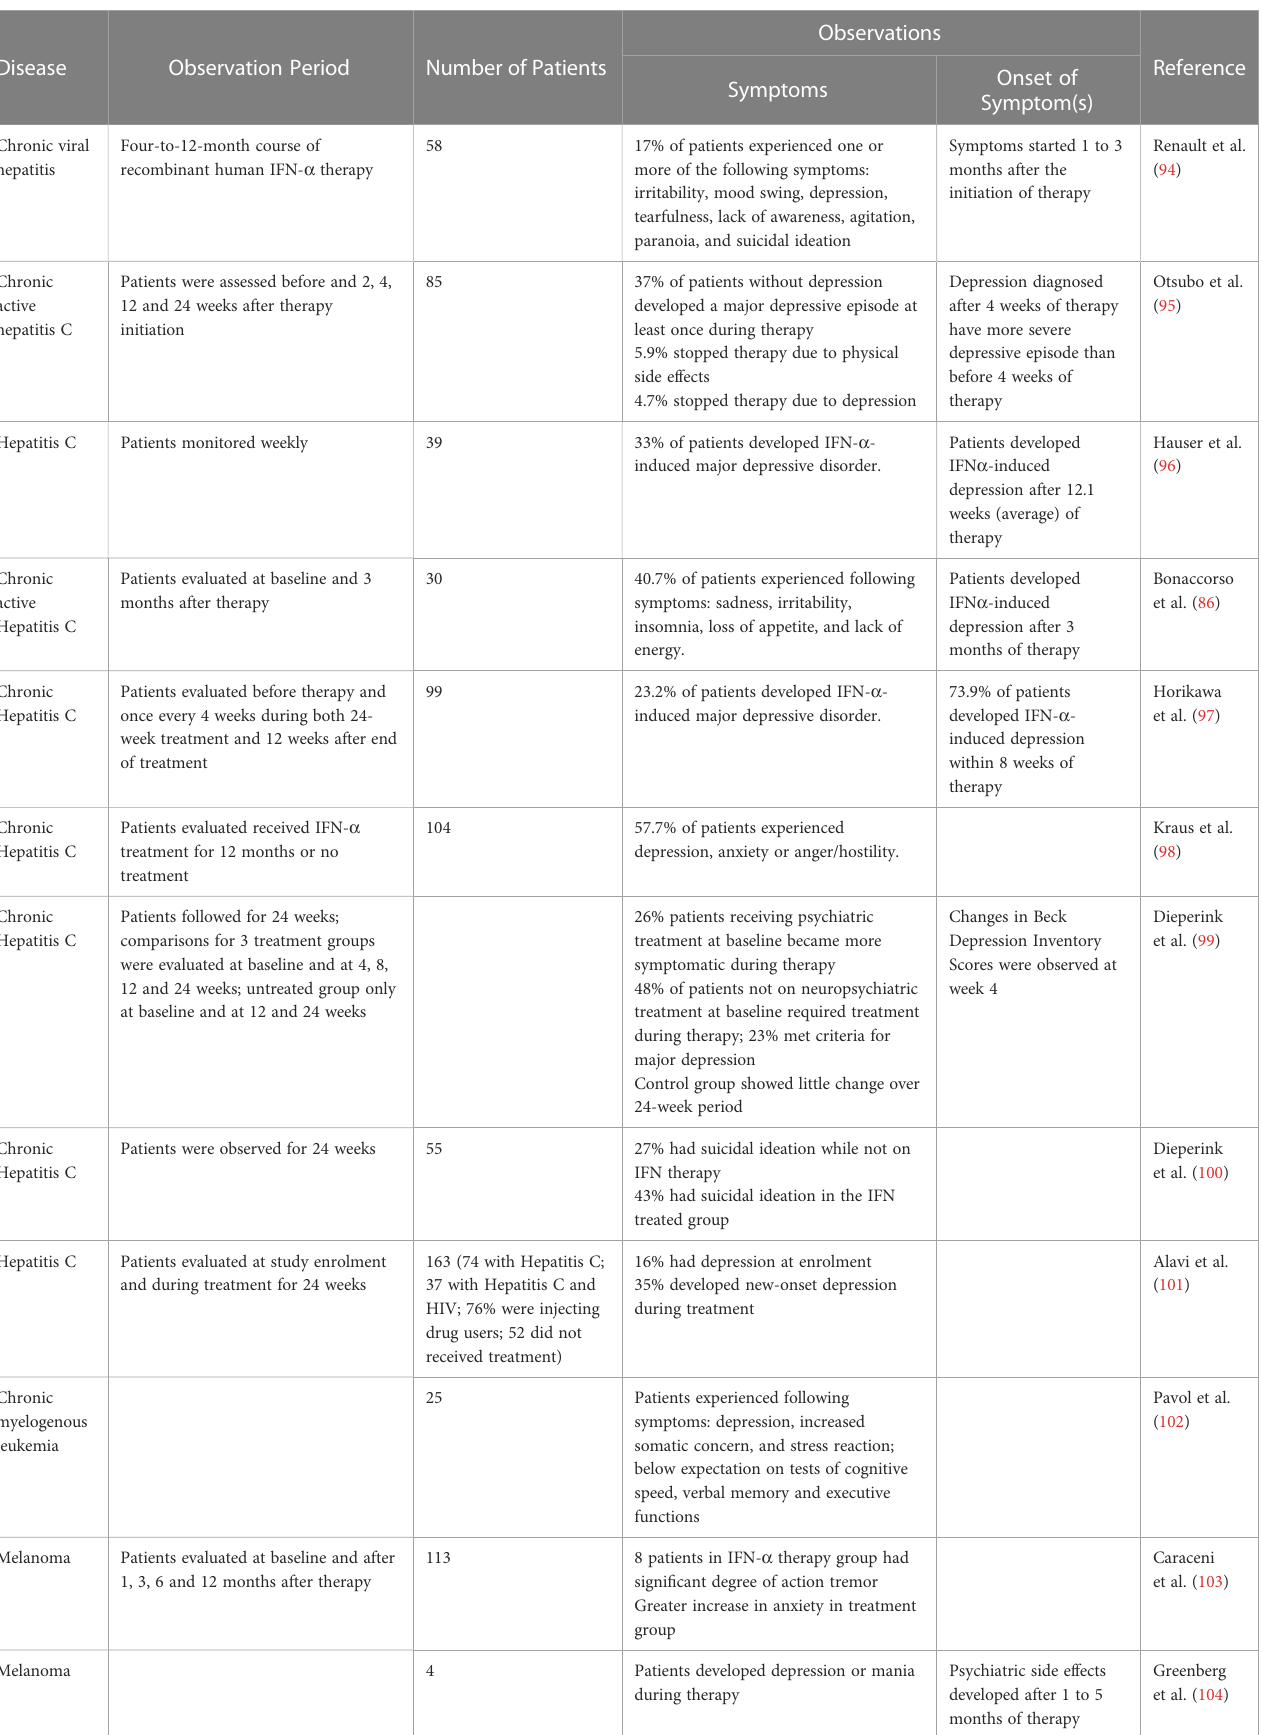
TABLE 5 IFN- a treatment and depression in patients with HCV and cancer.